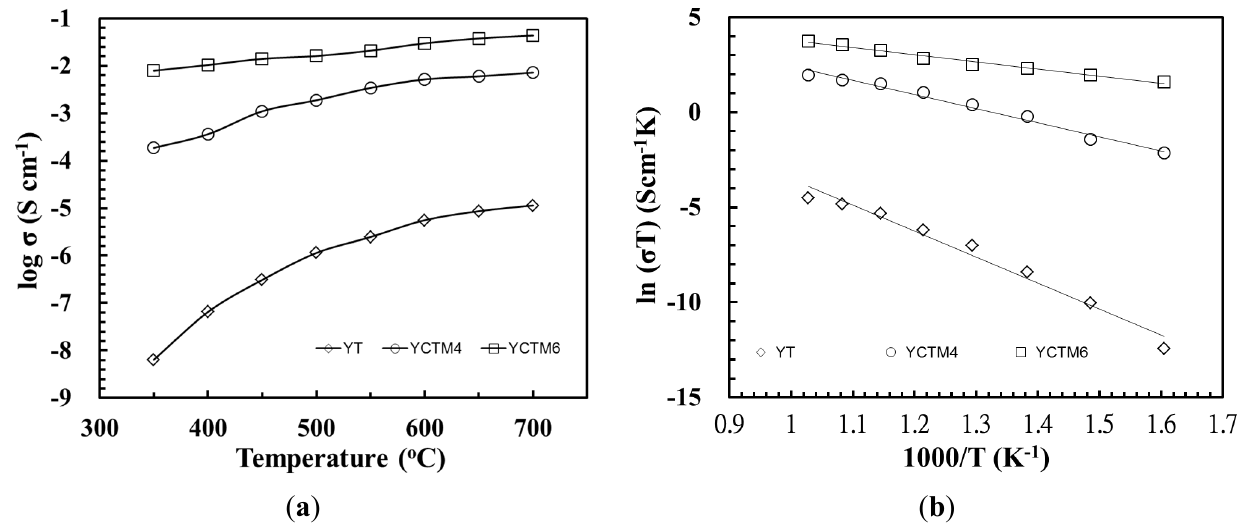
Figure 6. log σ and ln ( σ T) of 1500 °C/6 h sintering YT, YCTM4, and YCTM6 ceramics. ( a ) log σ ; ( b ) ln ( σ